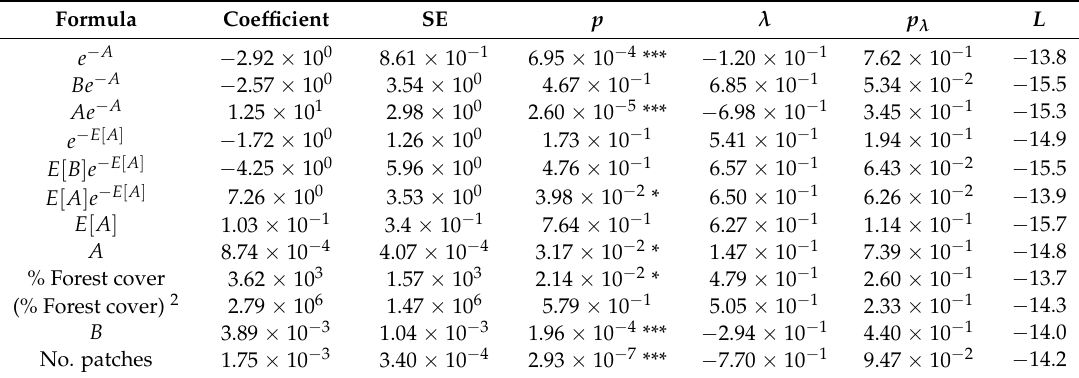
Table 3. Explanatory power of county-level landscape risk